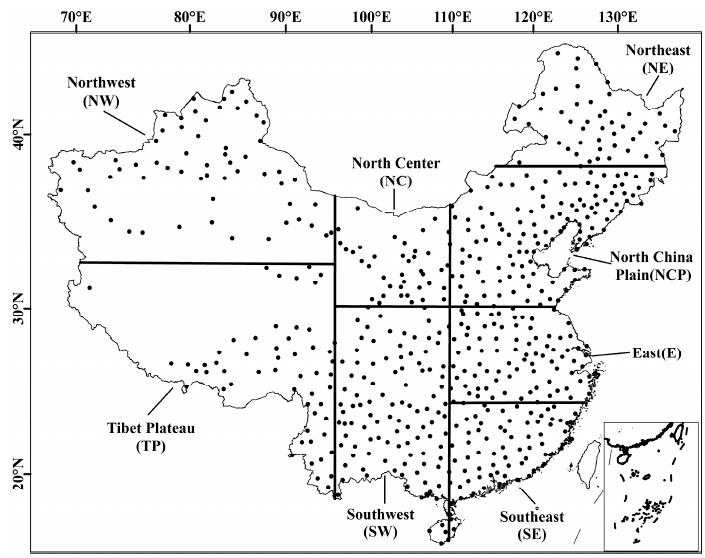
Figure 2. Locations of meteorological stations in China. The eight regional abbreviations are shown in the figure. This map was modified from Liu et al. [13]. Table 2. Climate factor characteristics in the eight climatic regions from 1998 to 2001. Region